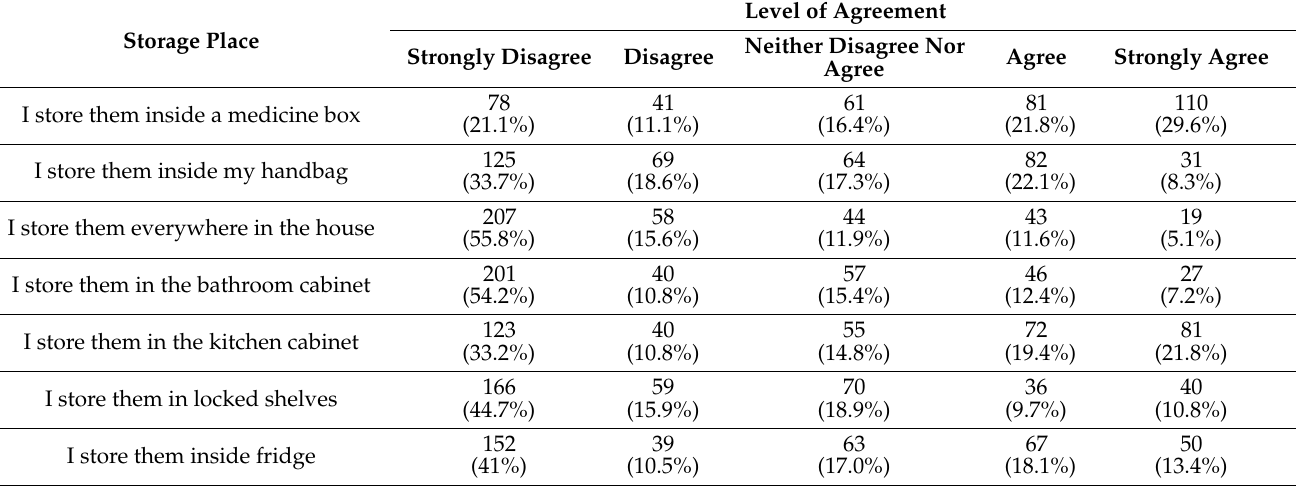
Table 3. Storage methods for pharmaceuticals.